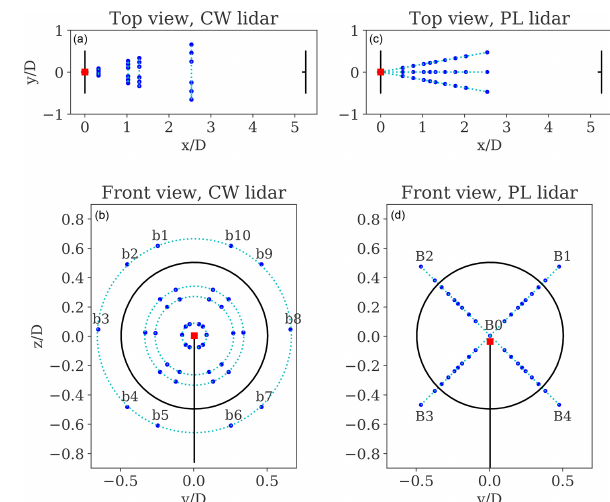
Figure 2. Top and front views of the CW lidar (a, b) and PL li- dar (c, d) scanning patterns shown by the blue dots. The trajectory of the lidar beams is illustrated by the dotted lines in cyan. The bins/beams notation is also given. The location of the lidars on T04 is shown with a red square marker. The reference coordinate system has an origin at the hub centre with the x axis in the mean wind direction. The distances are normalized with respect to the rotor di- ameter D